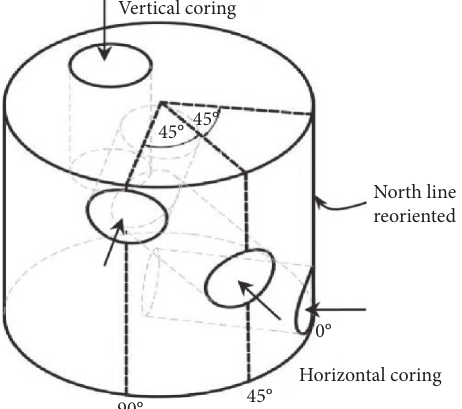
Figure 4: Four-direction sampling of reorientation